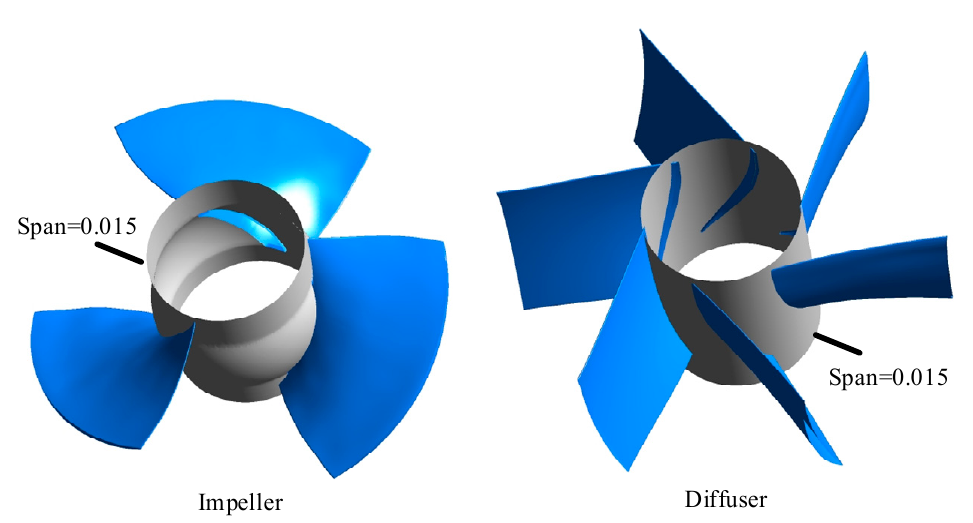
Figure 10. The cylindrical cross-section for impeller and diffuser.